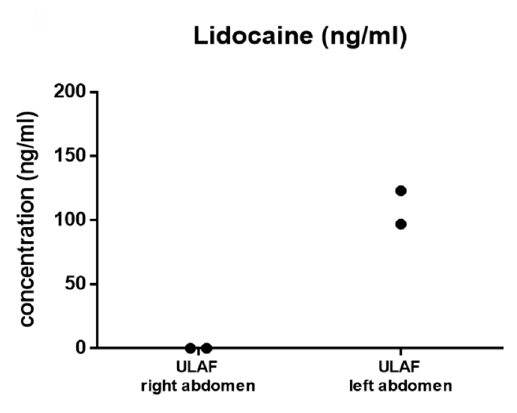
Figure 7. The results of the semiquantitative analysis with a GC-MS method of the unprocessed fluid portion (ULAF) of the right and left lower abdomen are shown. To evaluate the method, the lidocaine concentration was determined in 2 patients. The right abdomen, which served as a control, was free of lidocaine.